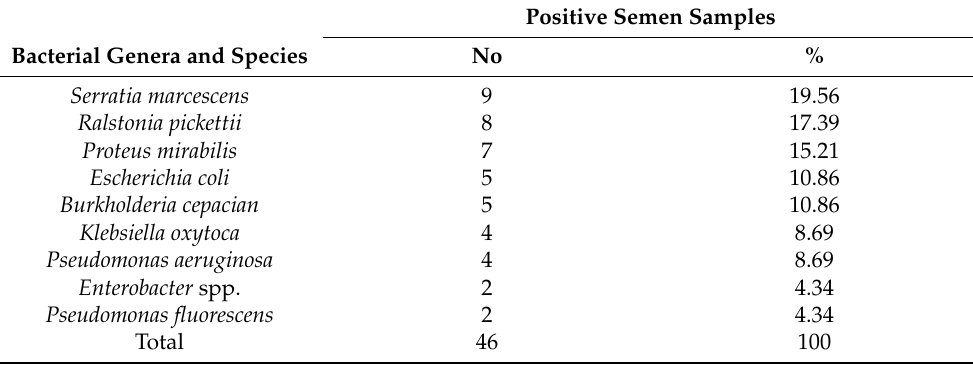
Table 1. Synopsis of gram-negative bacterial genera and species isolated from doses of diluted boar semen (DS) isolated in pure culture or in mixed